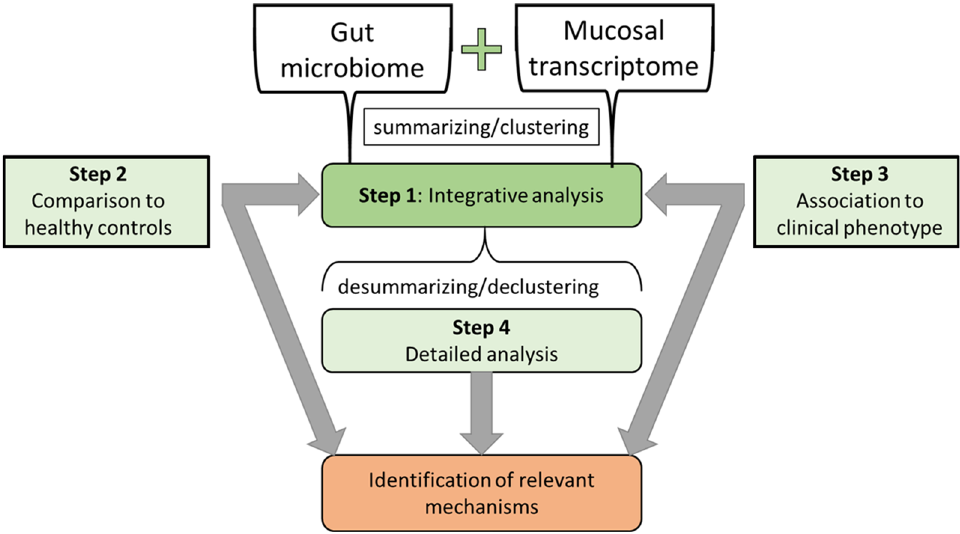
Figure 2. Concept of the stepwise integrative analysis